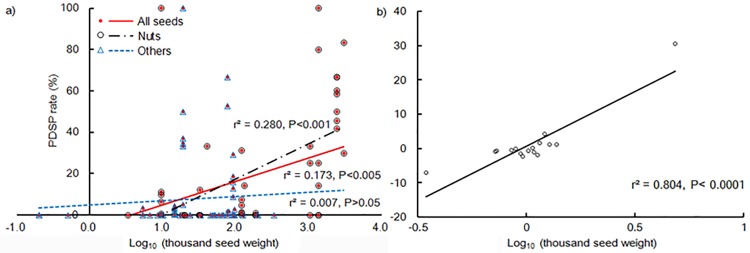
Relationship between PDSP rate and seed mass (g; log10thousand seed weight).(a) Pearson correlation coefficients between PDSP rate and seed mass., Different lines indicate the correlations between PSDP rate and seed mass of all species, species with nuts, and species with other fruit types. (b) Independent contrast correlations for the 17 species in the community.